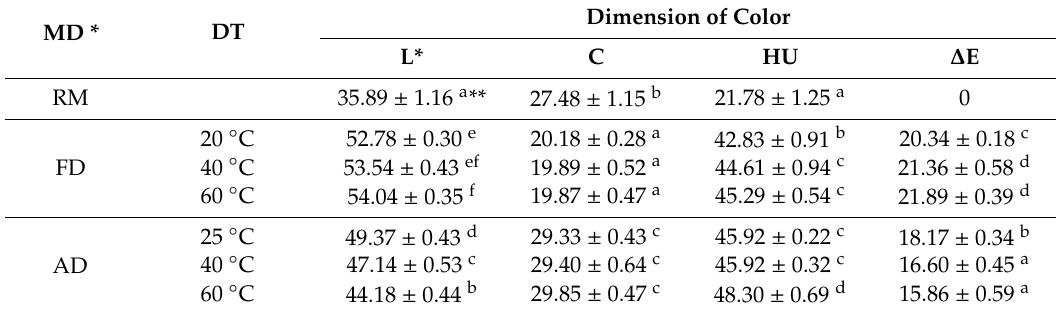
Table 6. E ff ect of the drying method on the color of wild strawberry